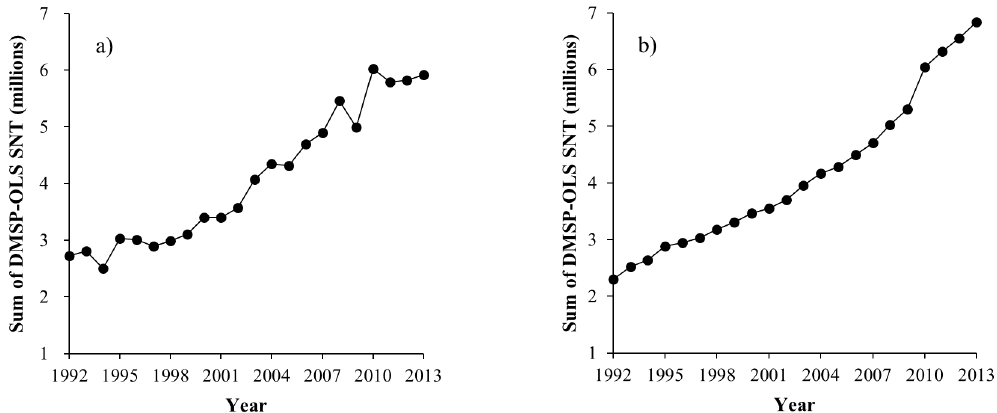
Figure 5. Sum of DMSP-OLS SNT data based on ( a ) intra-annual composition and ( b ) inter-annual series correction.